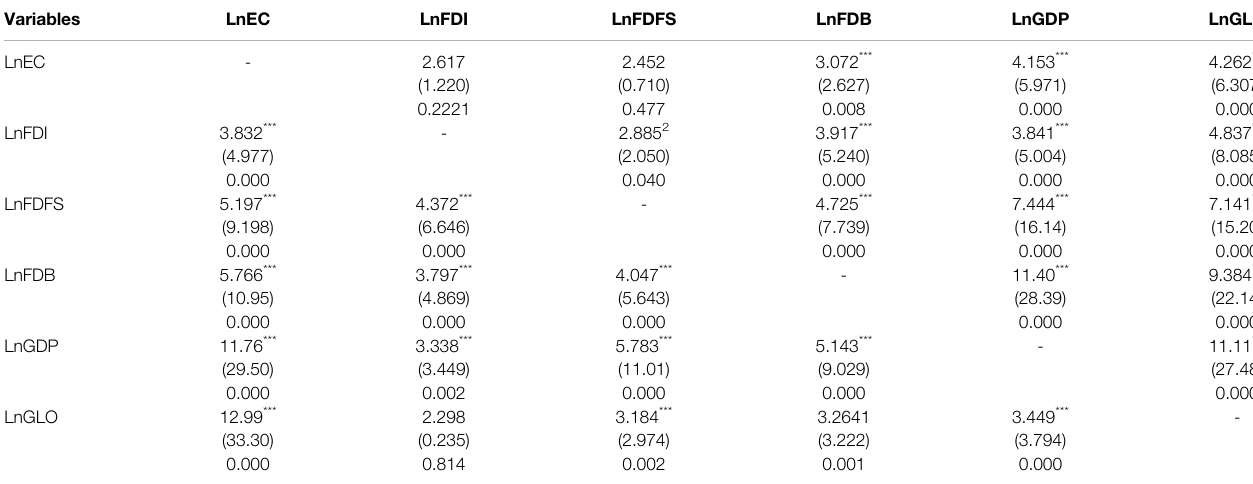
TABLE 8 | Results of Dumitrescu-Hurlin (DH) panel causality.